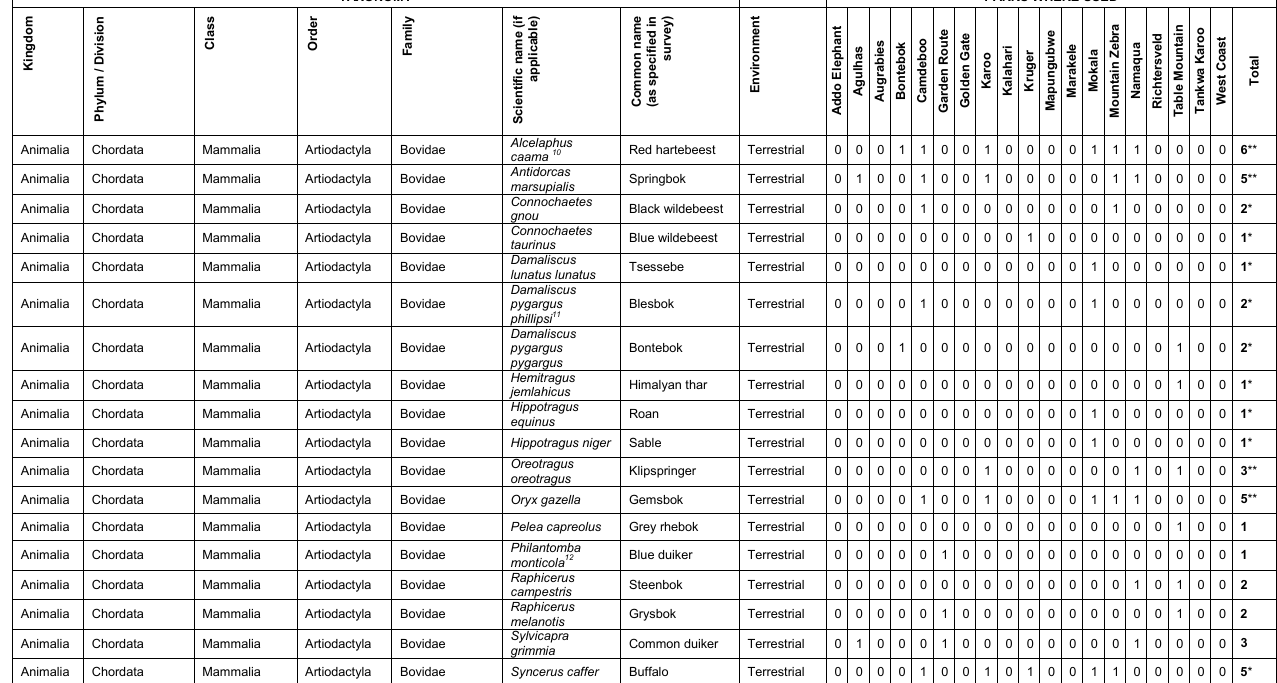
Damaliscus pygargus phillipsi 11 Damaliscus Bontebok pygargus pygargus